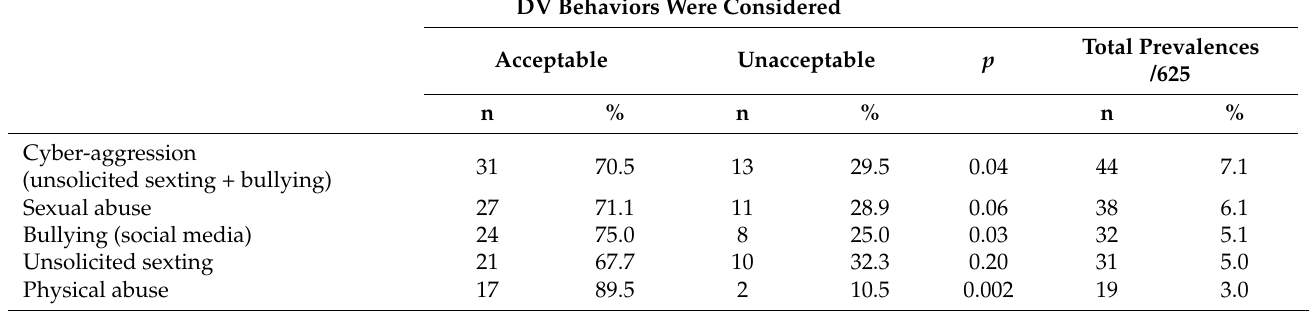
Table 3. Acceptability of DV *, cyber-aggression, sexual abuse, bullying, unsolicited sexting, and physical abuse; last 12 months (n = 625).